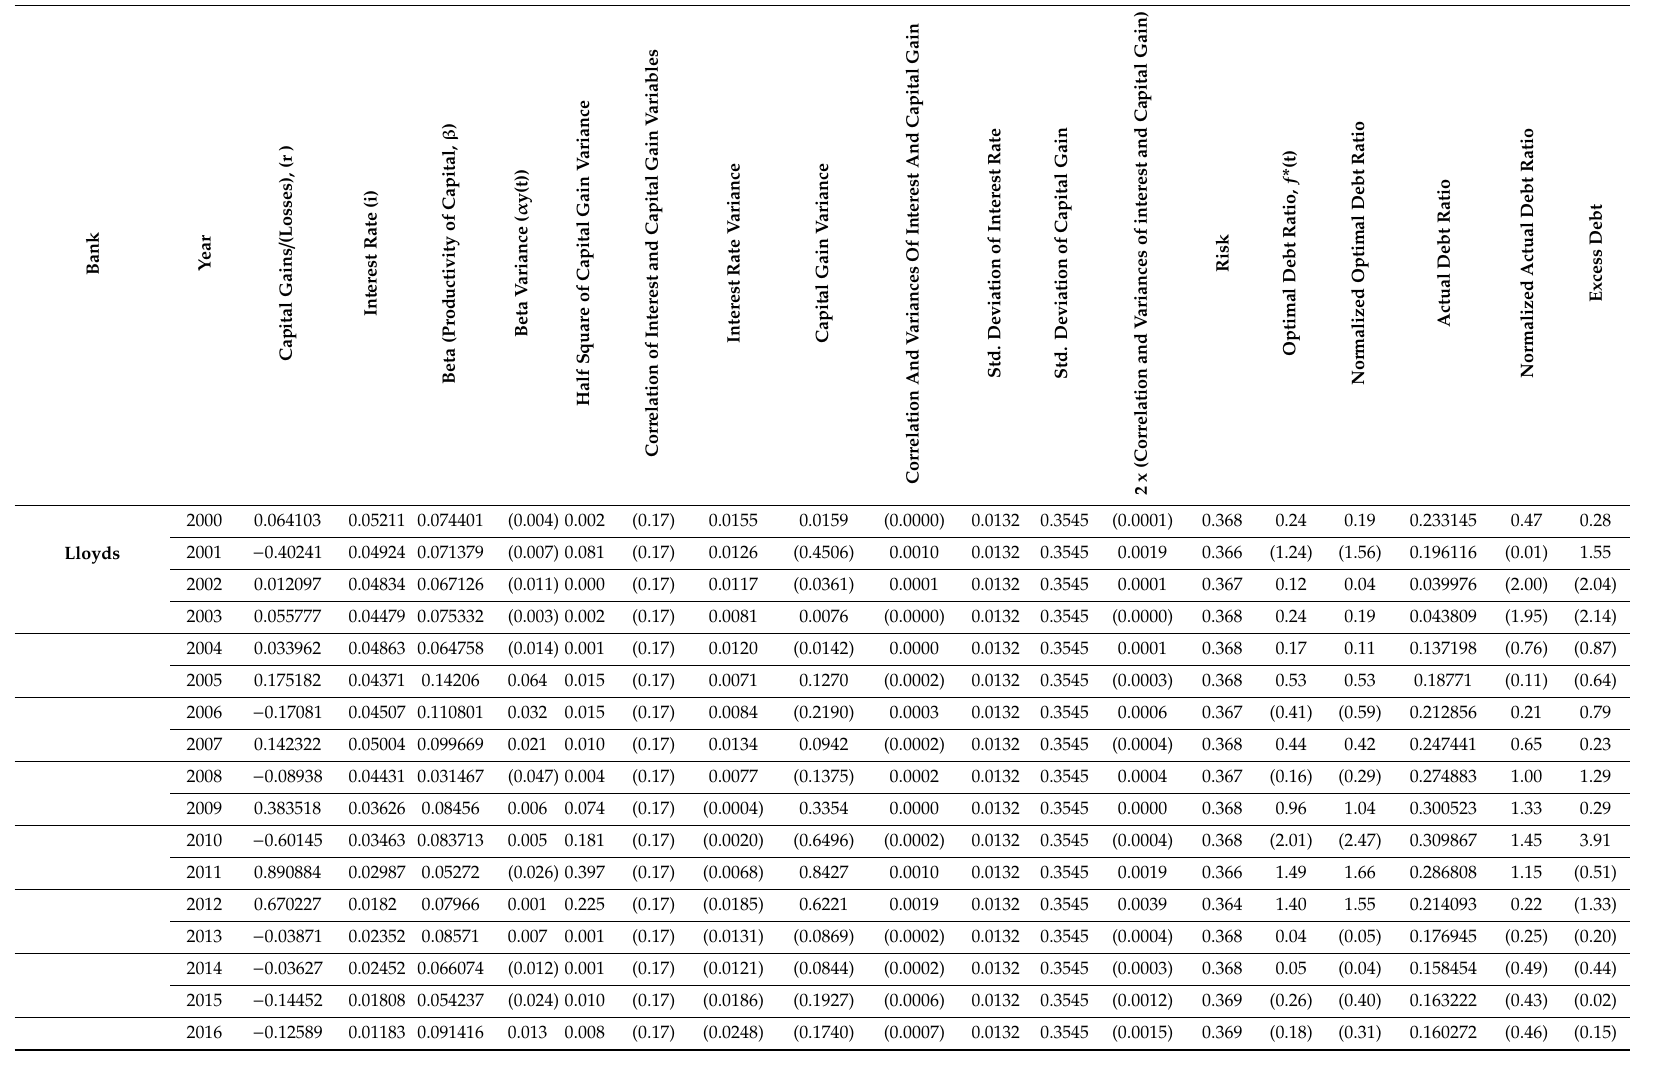
Table A19. Calculations of Optimal and Excess Debt: